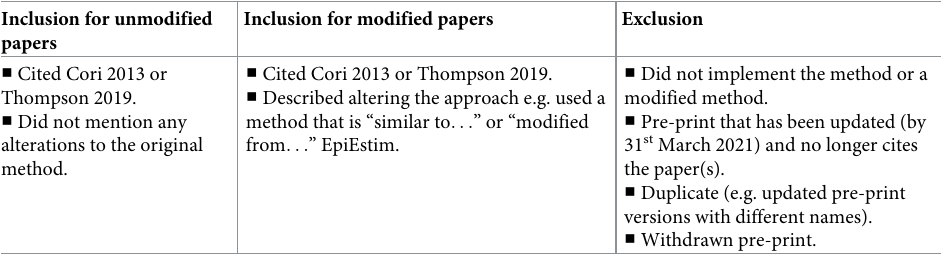
Table 1. Inclusion and exclusion criteria for the scoping